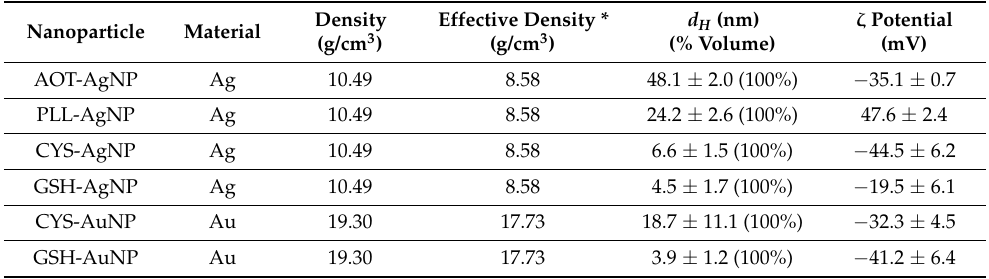
Table 1. Properties of the tested NPs used as input for the “in vitro dosimetry” web application. Nanoparticle Material